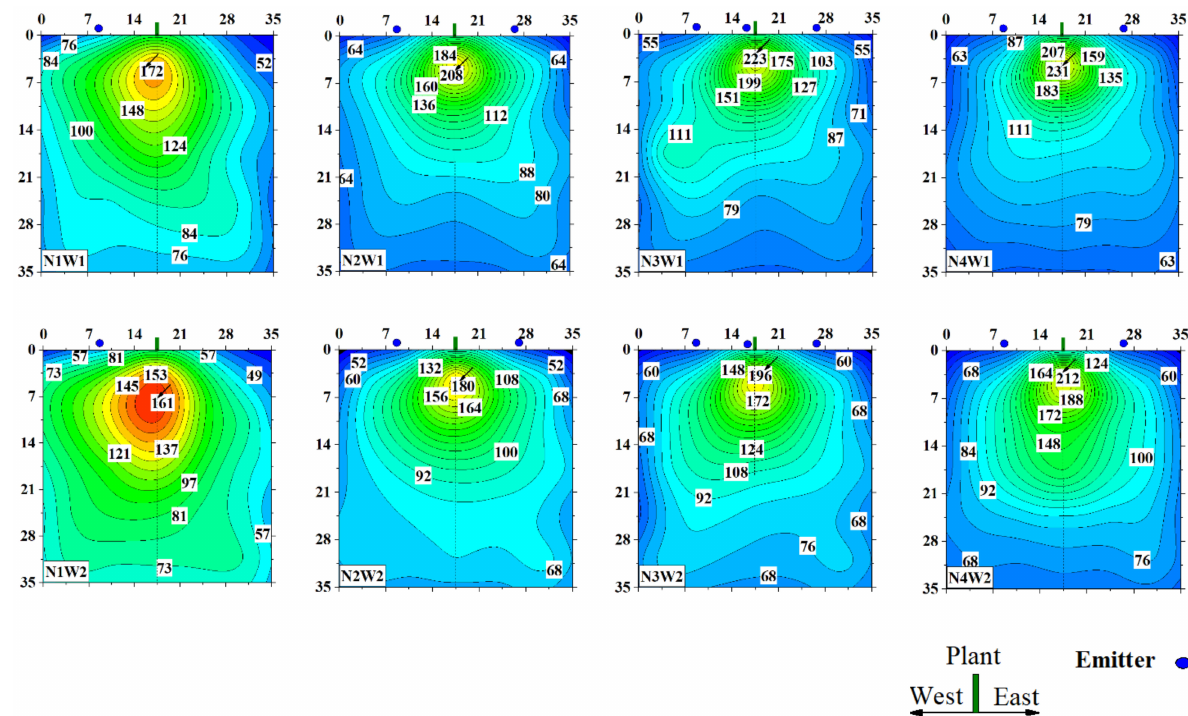
Figure 8. Effects of emitter density and irrigation levels on vertical root weight density (RWD, µ g cm − 3 ) distribution for the fall-winter cropping season (at the end of the cropping season; the maximum value is marked by a solid